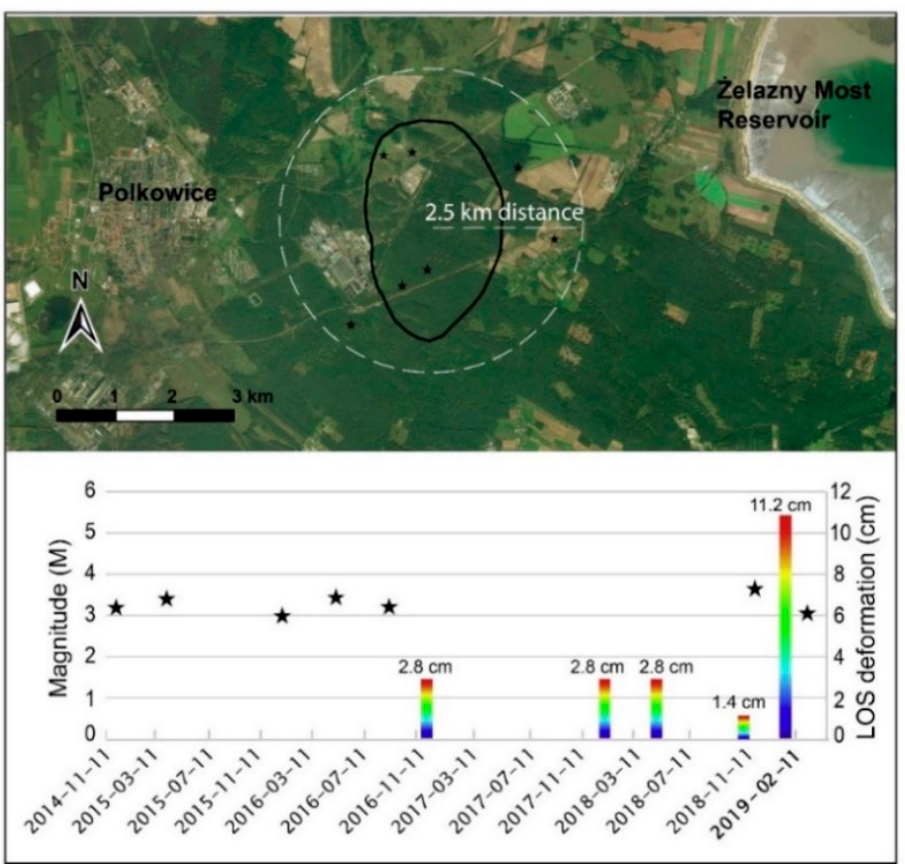
Figure 11. Epicenters time distribution vs. deformation pulses for a subsidence trough between Polkowice and the Ż elazny Most reservoir. The seismic events were within 2.5 km from the center of the subsidence trough.